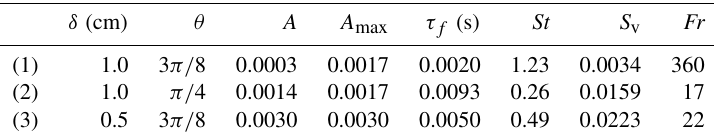
Table 5. Sets of vortex and particle parameters chosen for numerical simulation. St , S v and Fr are mean values. Only sets (1) and (2) give the visual effects of the cloud